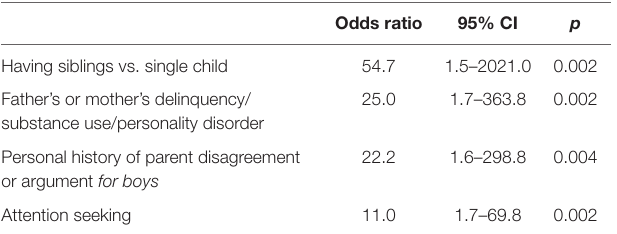
TaBle 5 | Variables associated with the borderline personality disorder traits group in adolescents: multivariate logistic regression model ( n = 58).